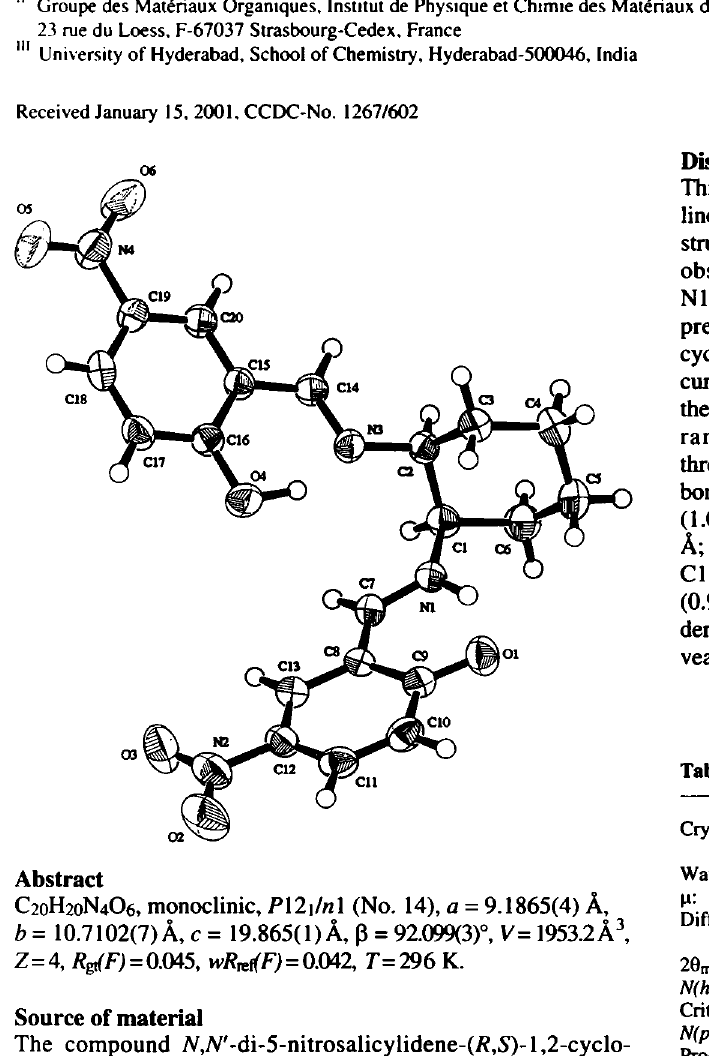
Table 2. Atomic coordinates and displacement parameters (in Ä 2